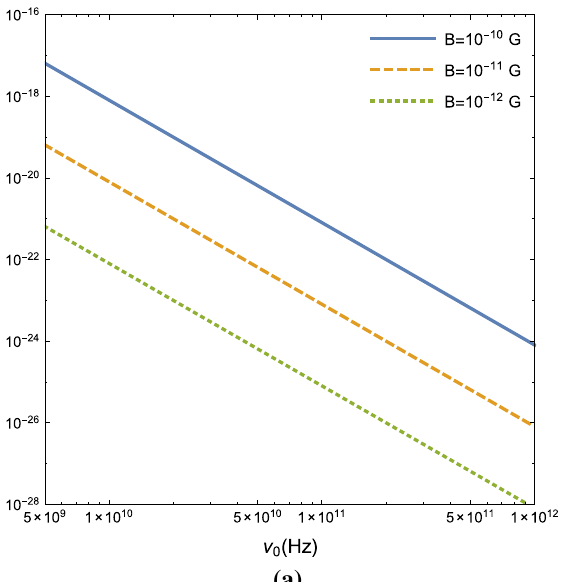
Fig. 2 In a logarithmicscaleplotsoftherootmeansquareofthedegree of circular polarization P rms ν 0 for values of B e 0 are shown. In b logarithmic scale plots of the root mean square of the